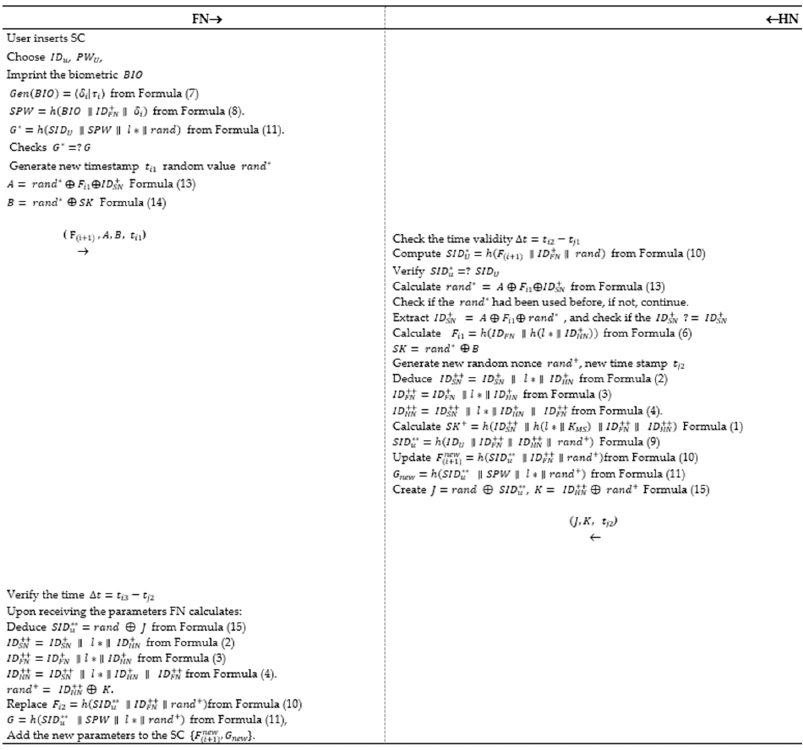
Figure 3. P-I: Three-factor authentication and key agreement protocol.